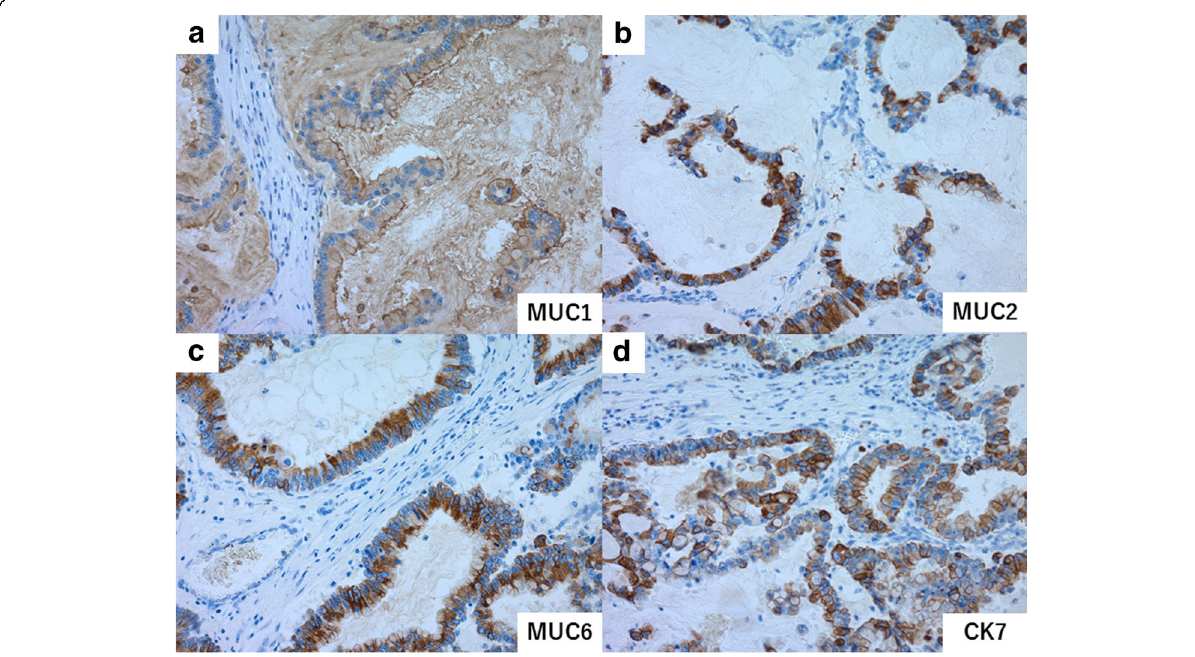
Fig. 4 Positive immunohistochemical staining for a MUC1, b MUC2, c MUC6, and d